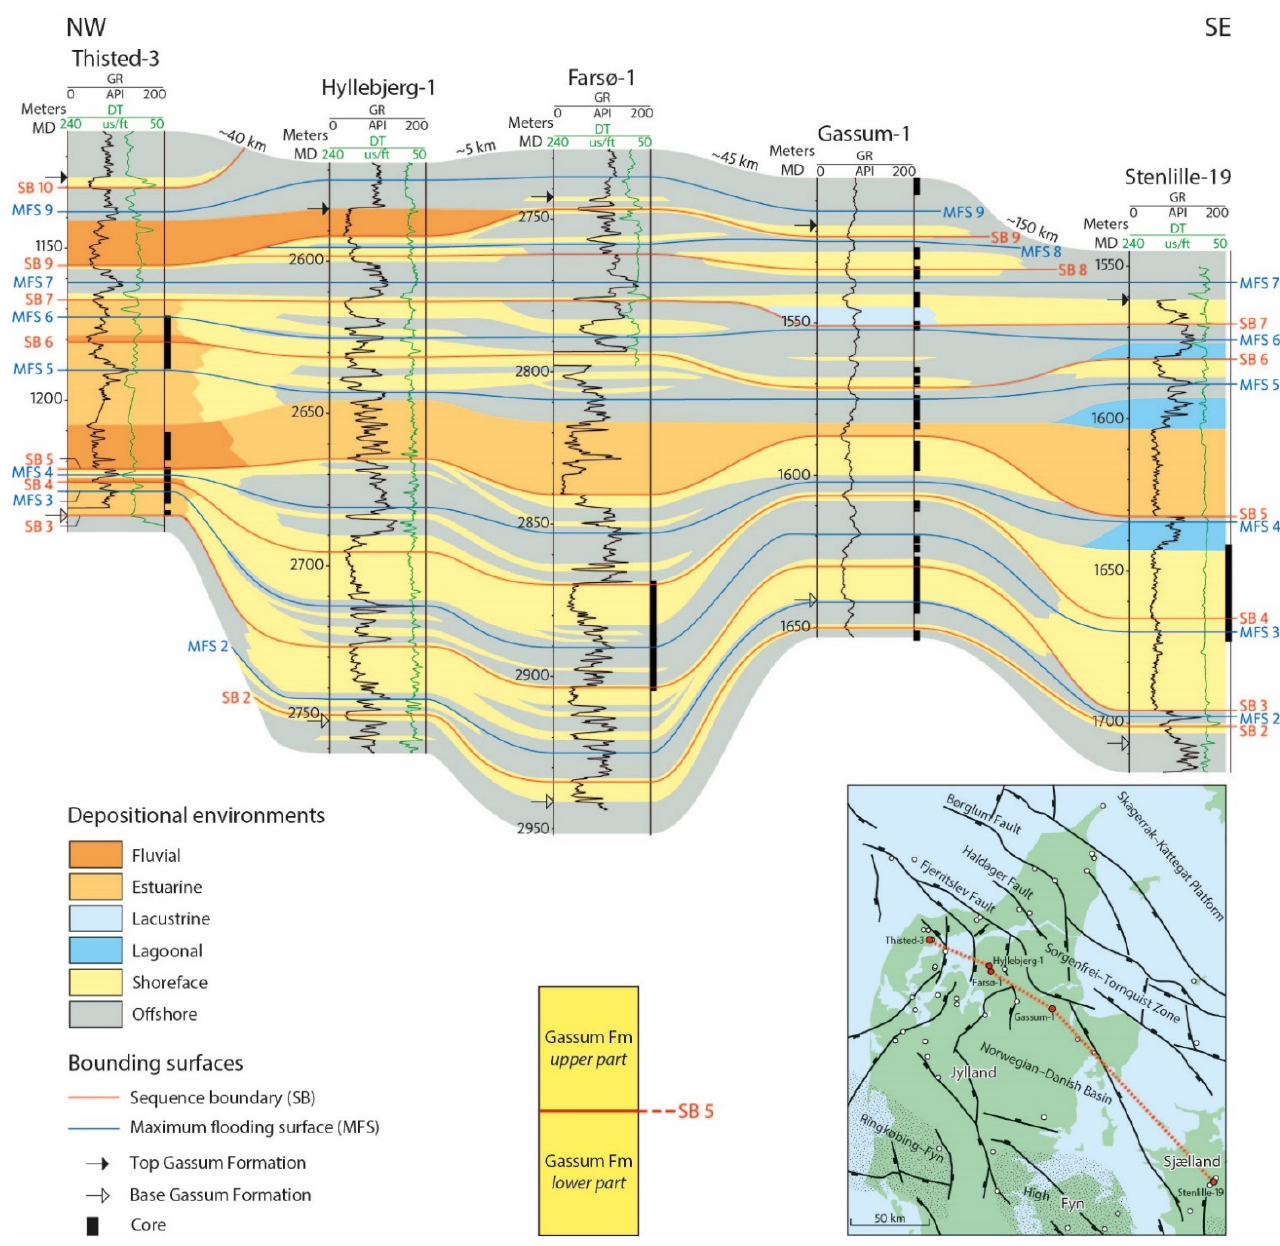
Figure 3. Wireline logs of Gassum Formation from five wells in the Norwegian-Danish Basin with interpreted depositional environments, sequence stratigraphic boundaries and correlations between wells. The stratigraphic framework is based on [24]. The basinwide regression at SB 5 marks a change in zircon U-Pb ages and sediment composition in Jylland but not in Sjælland.